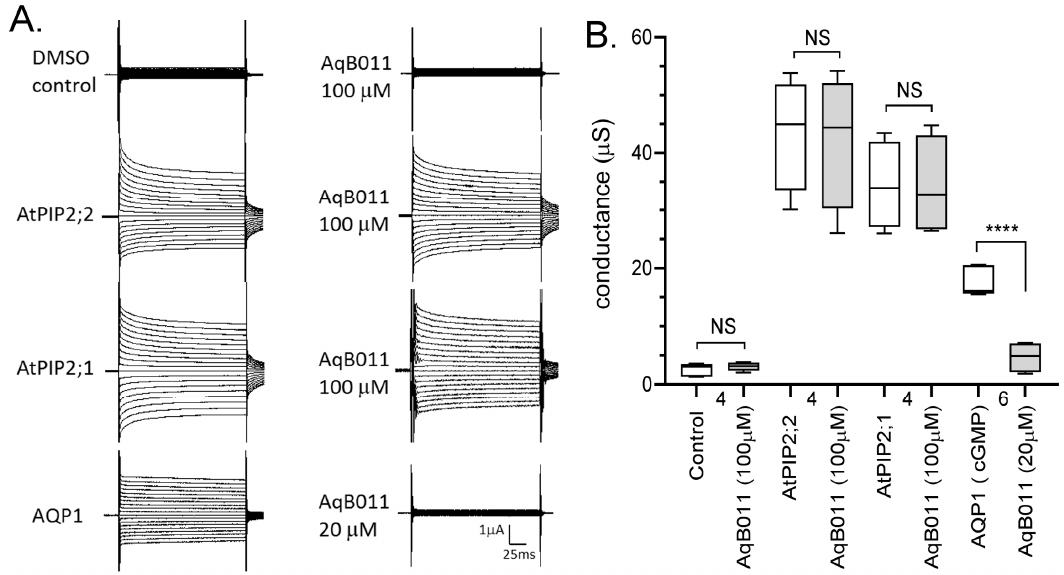
Figure 6. Effects of the arylsulfonamide compound AqB011 on ionic current responses in oocytes expressing different classes of AQPs. ( A ) Responses were recorded for control (DMSO vehicle), and AtPIP2;1, AtPIP2;2, and HsAQP1 expressing oocytes before ( left ) and after 2 h incubation ( right ) in AqB011 at the indicated doses. HsAQP1 was blocked by 20 µ M AqB011; AtPIP2;1 and AtPIP2;2 currents were not affected by 100 µ M AqB011. ( B ) Box plot summary of the conductance levels before and after treatment with AqB011. **** ( p < 0.0001); NS (not significant); using ANOVA with post hoc Bonferroni tests; n values are below the x -axis.